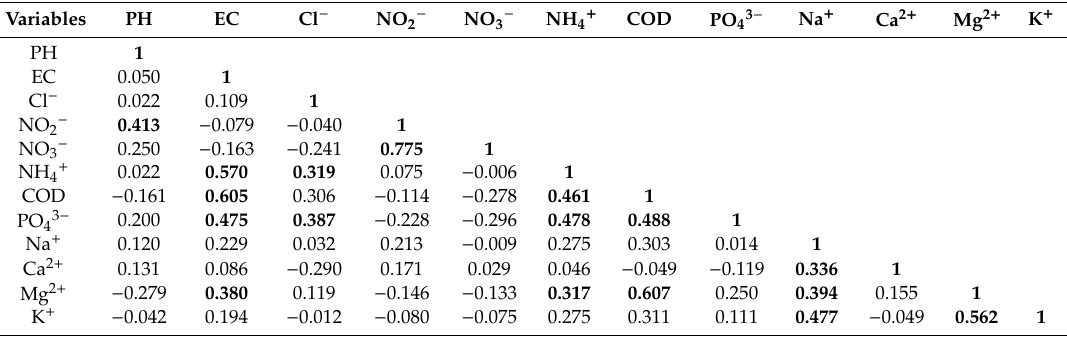
Table 2. Correlation matrices in the dry season using Spearman rank–order.